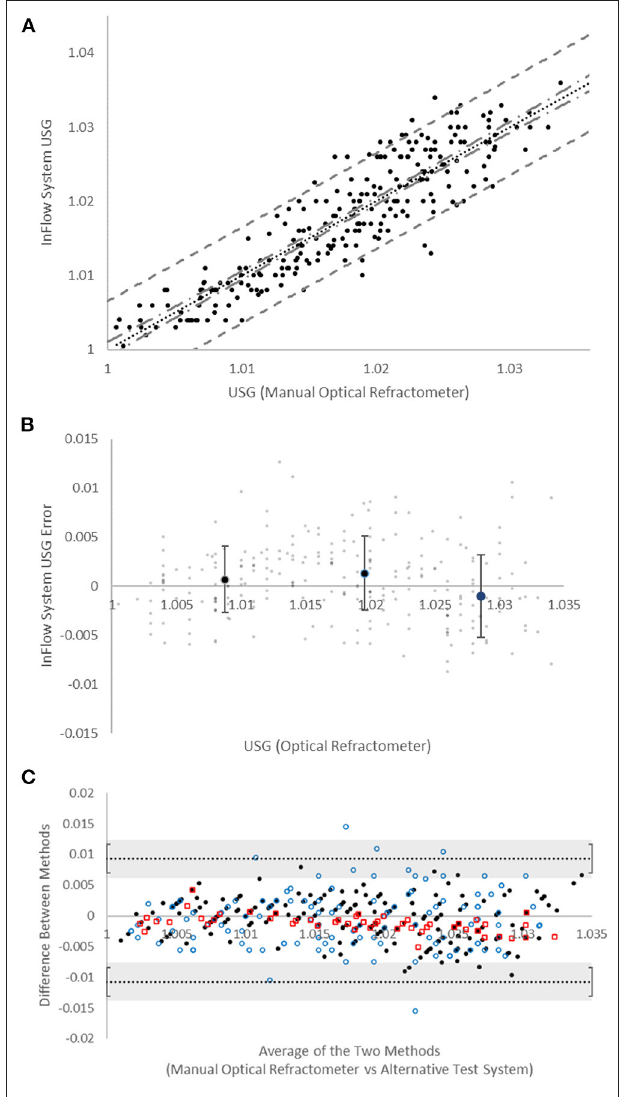
FIGURE 2 | Device accuracy. (A) Comparison of manual optical refractometer (x-axis) versus InFlow system (y-axis) results. Dotted line ( ... ) is linear regression ( r = 0.90). Dot-dash line ( - . - ) represents 95% confidence interval. Dashed line (- -) represents 95% prediction interval. (B) Bias (in USG “units”) of InFlow system vs. manual optical refractometry. Large dots represent averages at each USG range ( < 1.015, 1.015 − 1.025, > 1.025). Error bars represent SD. Small dots represent individual test results. (C) Bland-Altman plots of agreement between the manual optical refractometer with the InFlow system ( ), the MISCO digital optical refractometer ( ), and the Atago digital optical refractometer ( ). All systems fall with the agreement limits set at the reference change value (0.010) for USG established via CV I and CV G (Cheuvront et al., 2010, 2011). Error bars represent the SD of the agreement